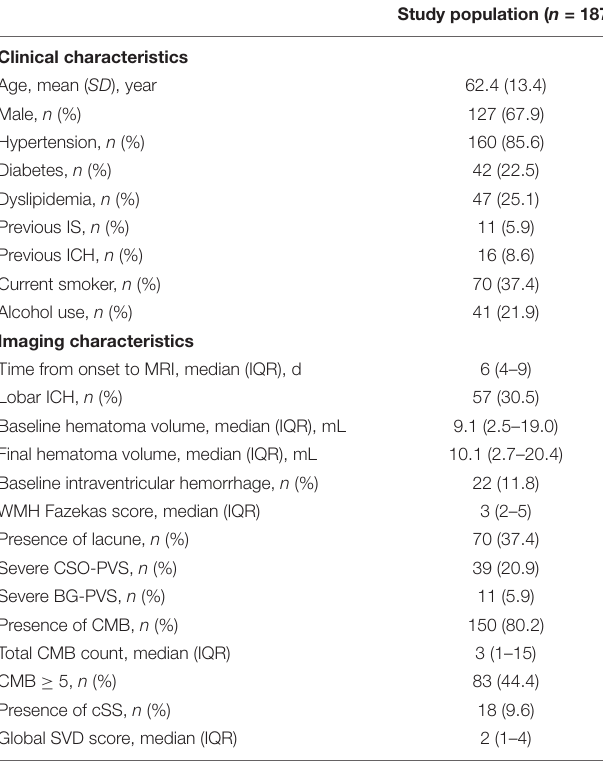
TABLE 2 | Baseline clinical and imaging characteristics of patients with small and non-small ICH. Study population ( n = 187)